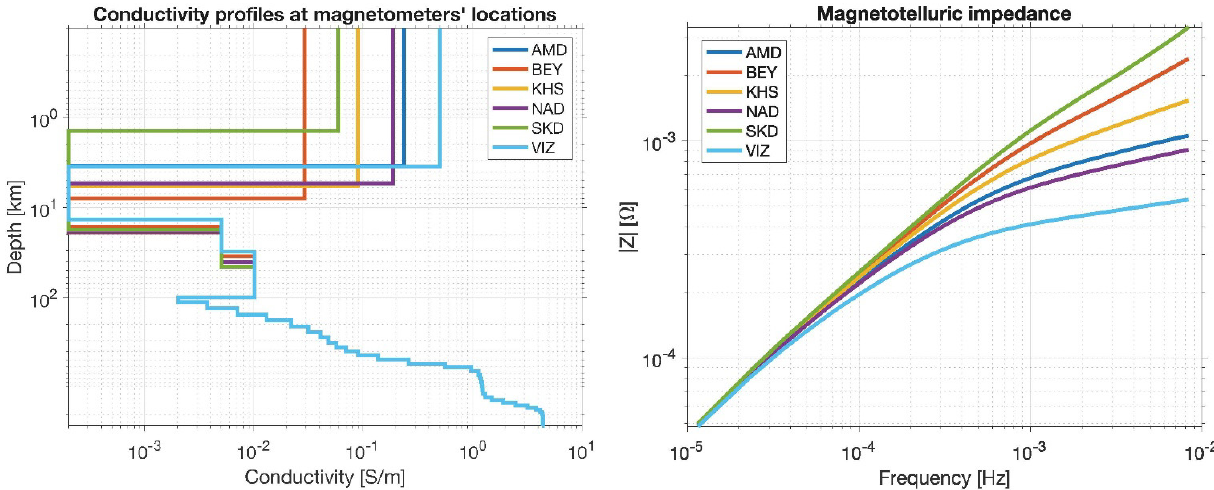
Figure 5. The conductivity profiles σ (z) and impedance dependence on frequency Z ( f ) for stations at Yamal derived from the global conductivity model. Below 100 km, profiles for each stations merge into one.